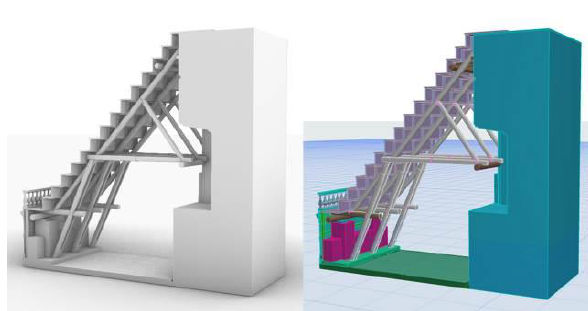
Figure 7 . Part of the free form model of the bleachers transformed into a model that can be used directly on the BIM platform. Figure 8 . Farnese Theatre before the 1944 destruction. Photography from Alinari